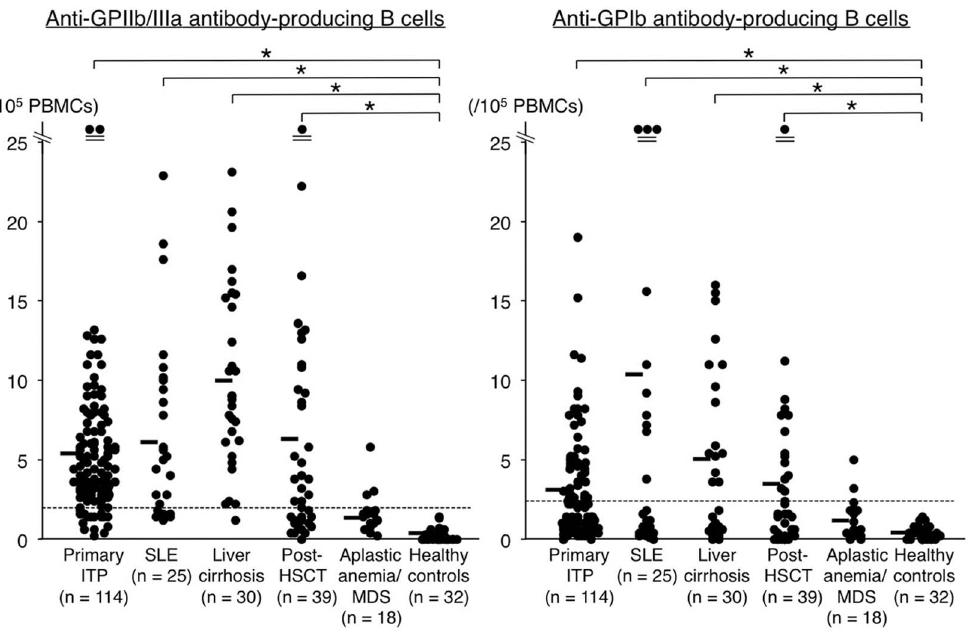
Figure 1. Anti-GPIIb/IIIa and anti-GPIb antibody-producing B cells in the circulation of patients with various thrombocytopenic conditions and healthy controls. Cut-off values for anti-GPIIb/IIIa and anti-GPIb antibody-producing B cells were 2.0 and 2.4 per 10 5 PBMCs, respectively. Bars indicate the mean, and asterisks indicate statistical significance ( P , 0.05). doi:10.1371/journal.pone.0086943.g001 PLOS ONE |